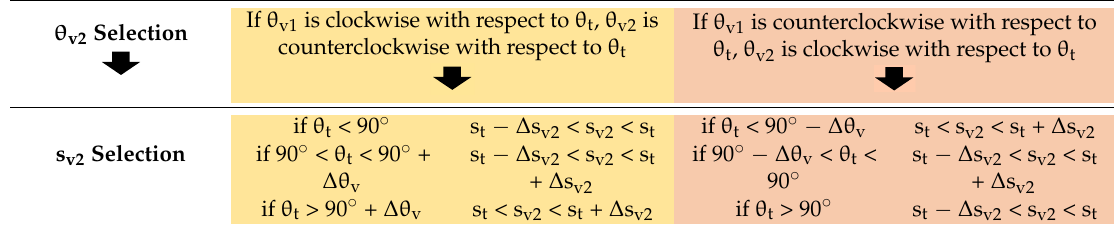
Table 2. Search logic for the Kelvin arms.